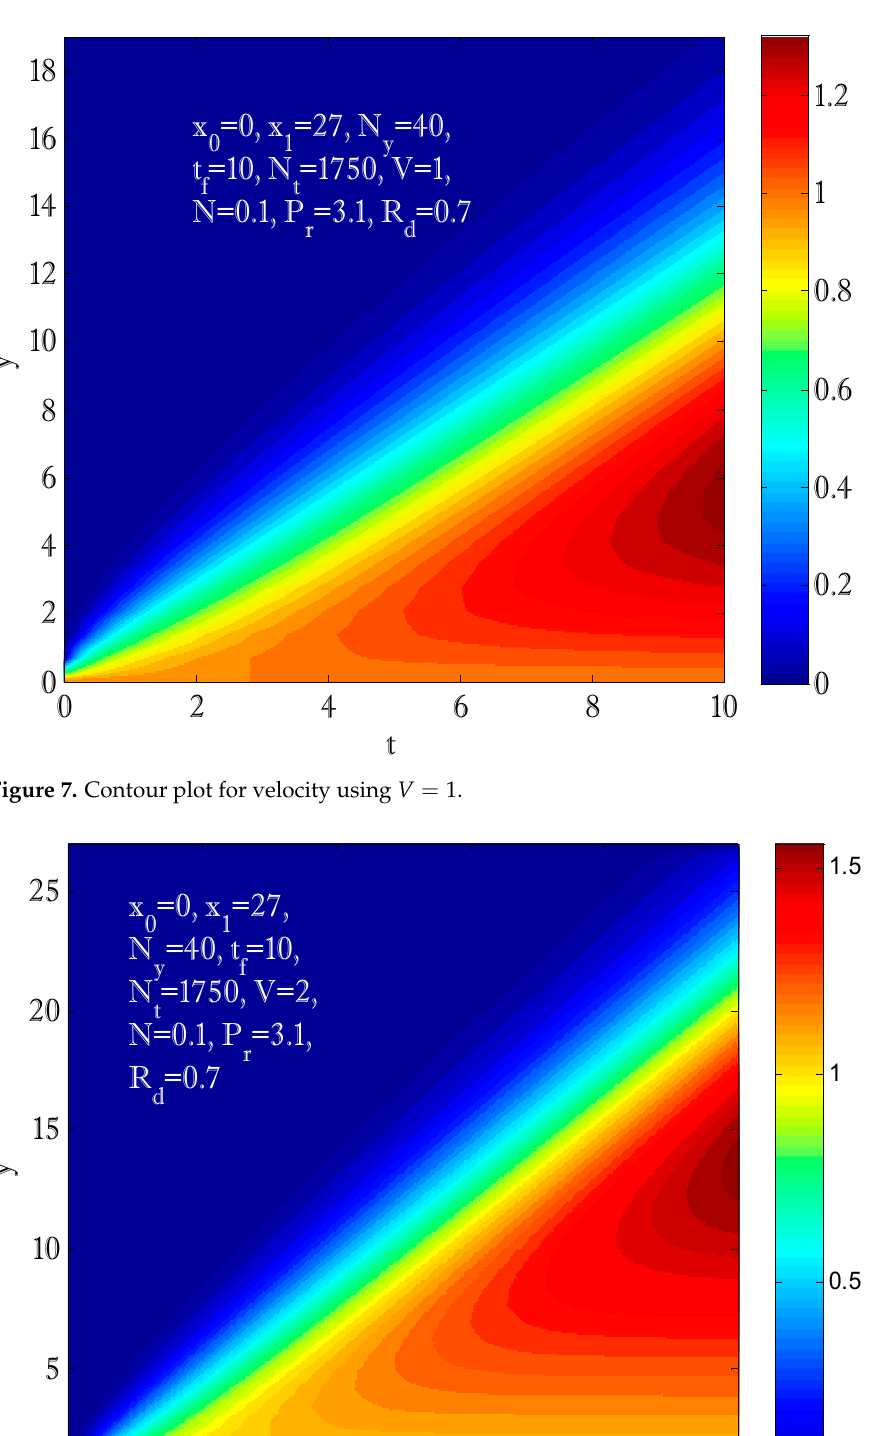
Figure 6. Contour plot for velocity using (cid:1848) = 0.5.